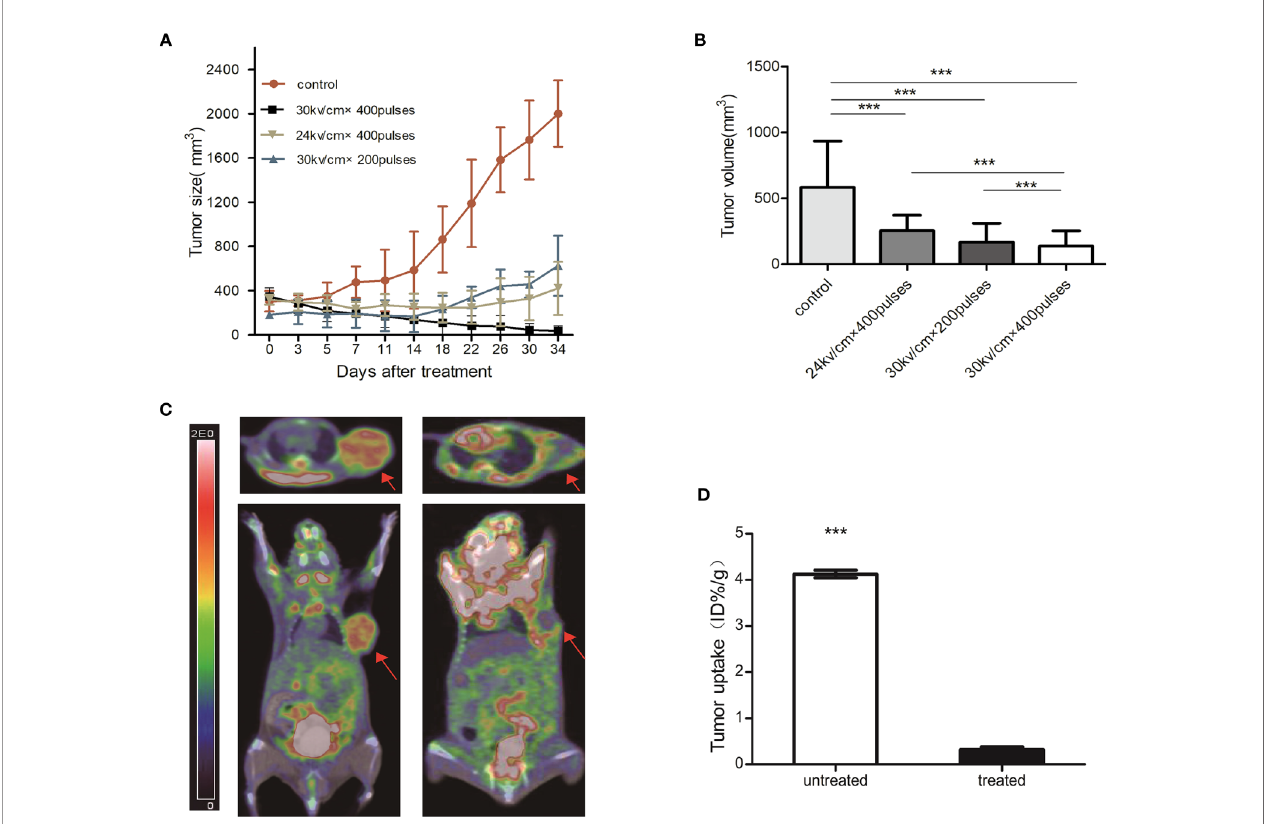
FIGURE 2 | (A) Growth curve of pancreatic cancer tumor from PDX models post-nsPEFs treatment. Tumor volume was determined using calipers after treatment with different parameters. (B) Tumor volume comparison 14 days after treatment. The tumor volume of treated mice decreased signi fi cantly compared with control which had no nanosecond pulsed electric fi elds treatment (*** p < 0.001). (C) PET/CT scans obtained at baseline and 3 days after nsPEFs treatment. Tumors had substantial initial FDG activity on the baseline fused FDG PET/CT images. FDG PET/CT scans obtained after nsPEFs showed limited metabolic activity. (D) Bar chart showing a signi fi cant difference in tumor uptake (ID%/g) between treated and untreated tumors 3 days after treatment (*** p <